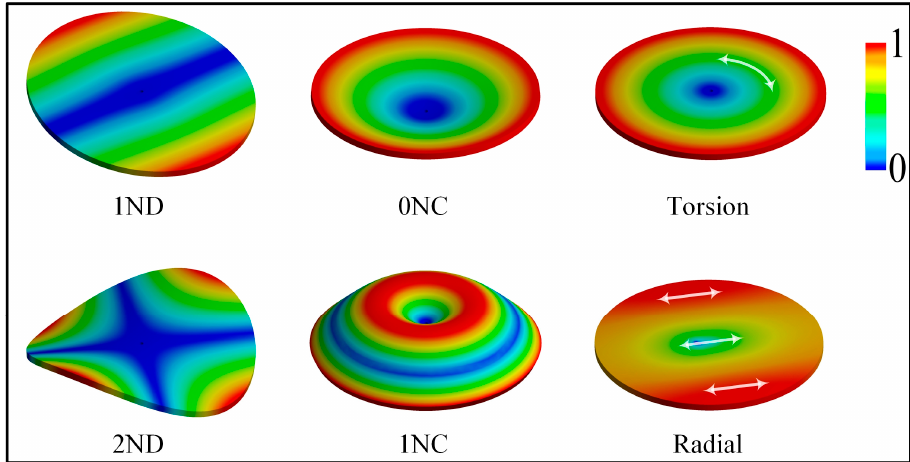
Figure 4. Schematic of vibration modes of a